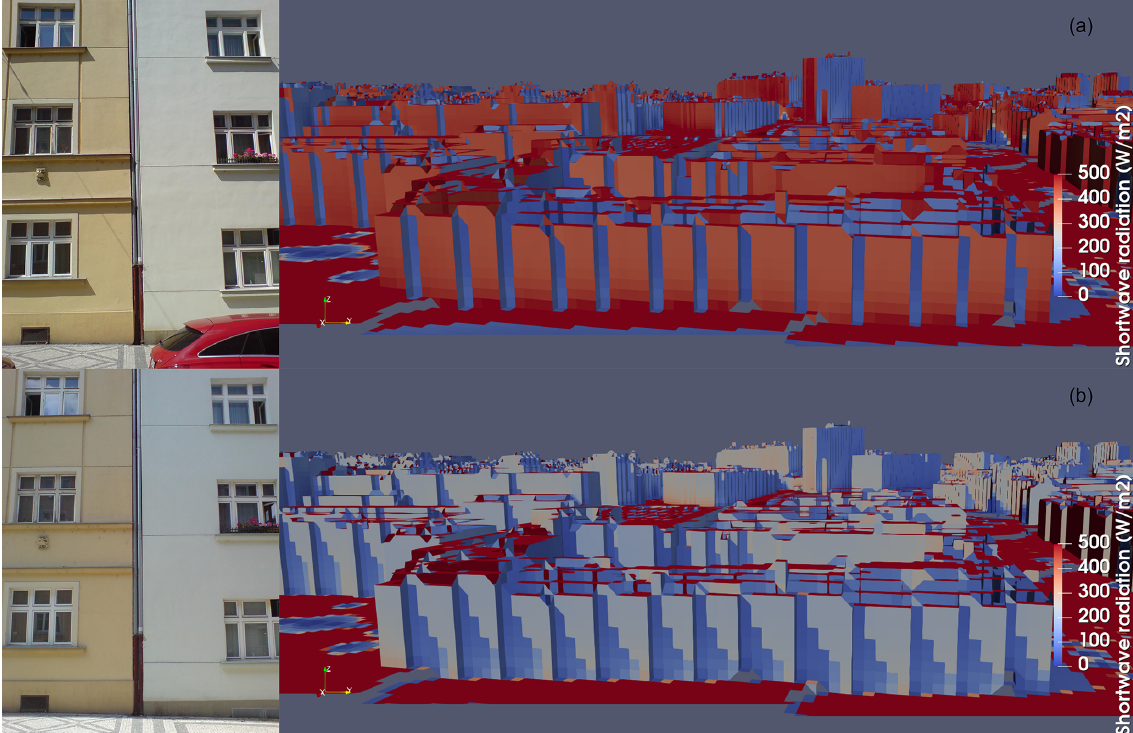
Figure 22. East-facing wall in N. A. Nˇekrasova Street around location 07-1_V (see Fig. 1 and the detailed location information in Supplement Sect. S3). The top row shows the observed photo on 20 July 2018 at 09:37UTC and the 3D view of the modelled incoming SW radiation on this wall at the corresponding time step, and the bottom row shows the same situation at 10:38UTC.